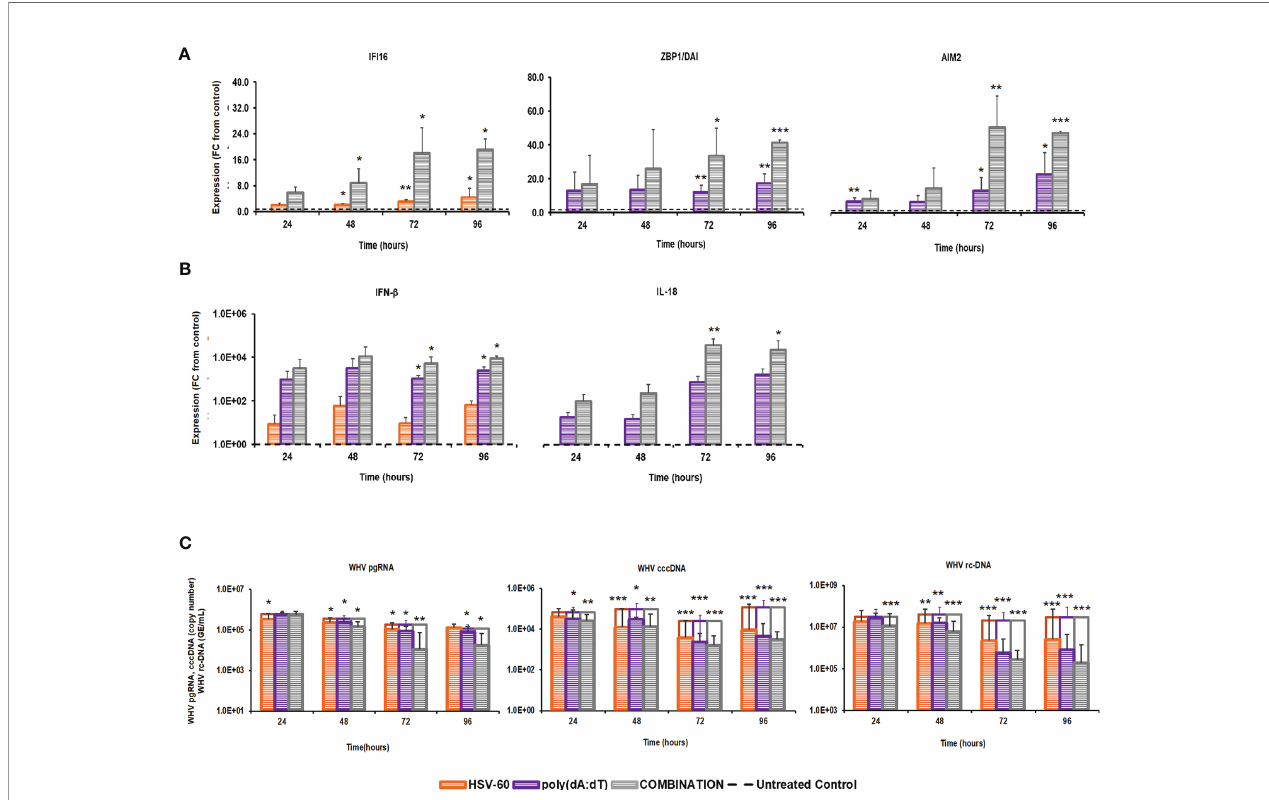
FIGURE 3 | Parallel agonistic activation of IFI16, ZBP1/DAI, and AIM2 receptor pathways enhances WHV suppression. PWHs generated from the liver of three woodchucks with CHB were treated with HSV-60 and poly(dA:dT), alone and in combination, at T0 and again at 48 hours. The fold-changes in transcript level of (A) IFI16, ZBP1/DAI, and AIM2 and (B) IFN- b and IL-18 over 96 hours are shown, when compared to their transcript level in untreated control PWHs from individual animals at each timepoint, which was set at 1.0 and is indicated by the dotted line. (C) The average changes in WHV replication (pgRNA and cccDNA) and secretion (rc-DNA) during mono and combination treatment are presented for untreated control (empty bars) and agonist-treated PWHs (colored bars) at each timepoint. Horizontal bars represent the standard error of the mean. P values representing statistical signi fi cance from untreated control PWHs are shown as * for <0.05, ** for <0.01, and *** for <0.001. FC,